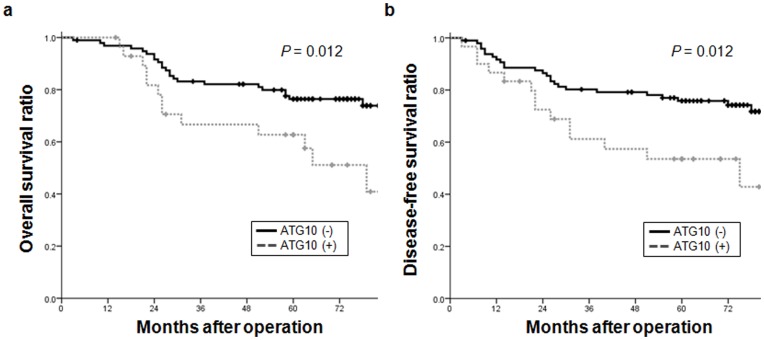
Relationship between ATG10 expression and survival of colorectal cancer patients.The relationship between ATG10 expression and 5-year disease-free survival (DFS) and overall survival (OS) rates of colorectal cancer patients were analyzed by Kaplan-Meier curves.